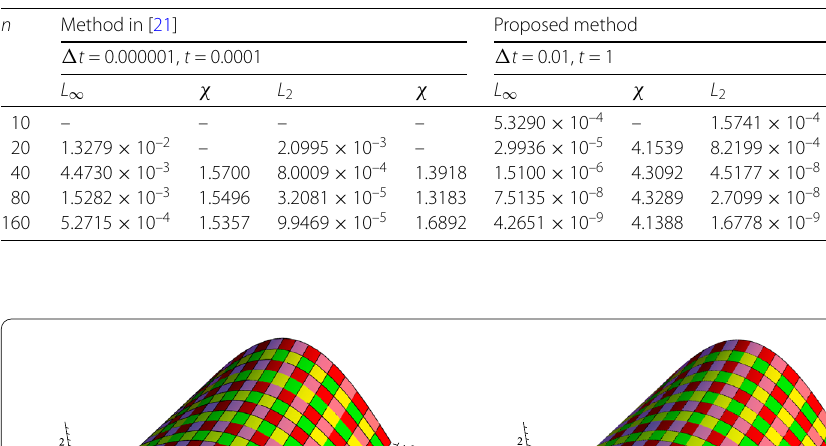
Table 2 Computational error norms and order of convergence for Problem 1 when (cid:12) t = h